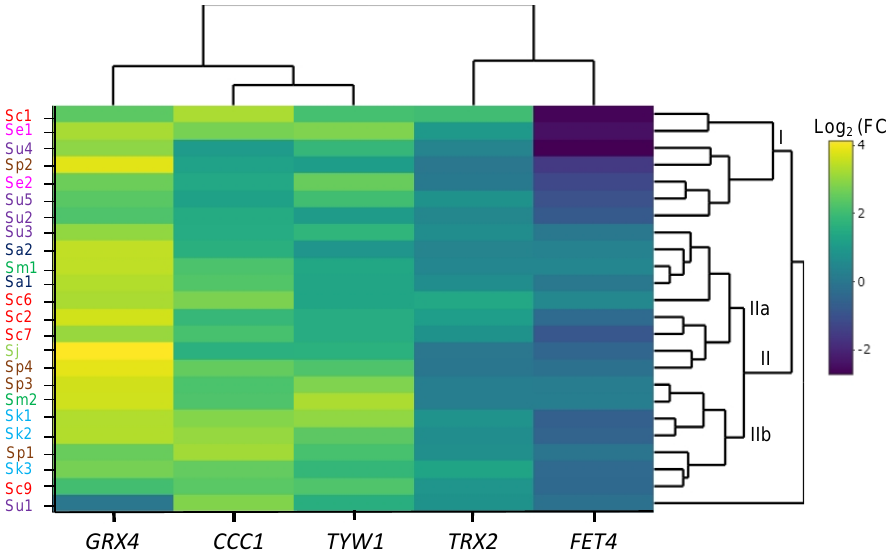
Figure 8. Effect of iron on gene expression in Saccharomyces strains. Yeast strains were exposed to 2 mM FAS for 1 h, as described in the Materials and Methods, and GRX4 , CCC1 , TYW1 , TRX2 and FET4 mRNA levels were determined by RT-qPCR. The heatmap represents the log 2 fold change between SC + 2 mM FAS and SC mRNA levels, with a hierarchical cluster calculated by the Euclidean distance. Higher fold changes are represented with yellow to light green and low fold changes are depicted with light to dark blue. mRNA levels were normalized using the ACT1 gene. Groups I, IIa and IIb are indicated. All values are the average of three independent biological